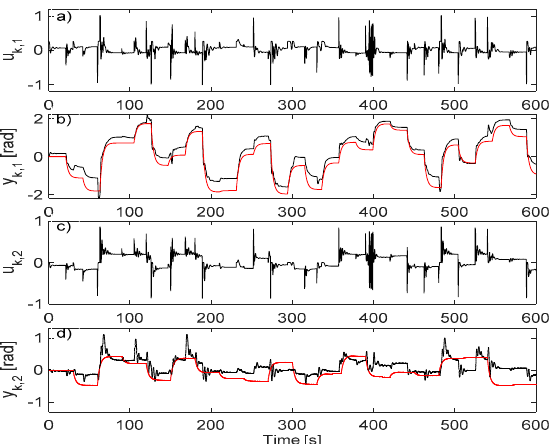
Figure 8. AI-VIRL NN controller: ( a ) u k ,1 ; ( b ) y k ,1 (black), y m